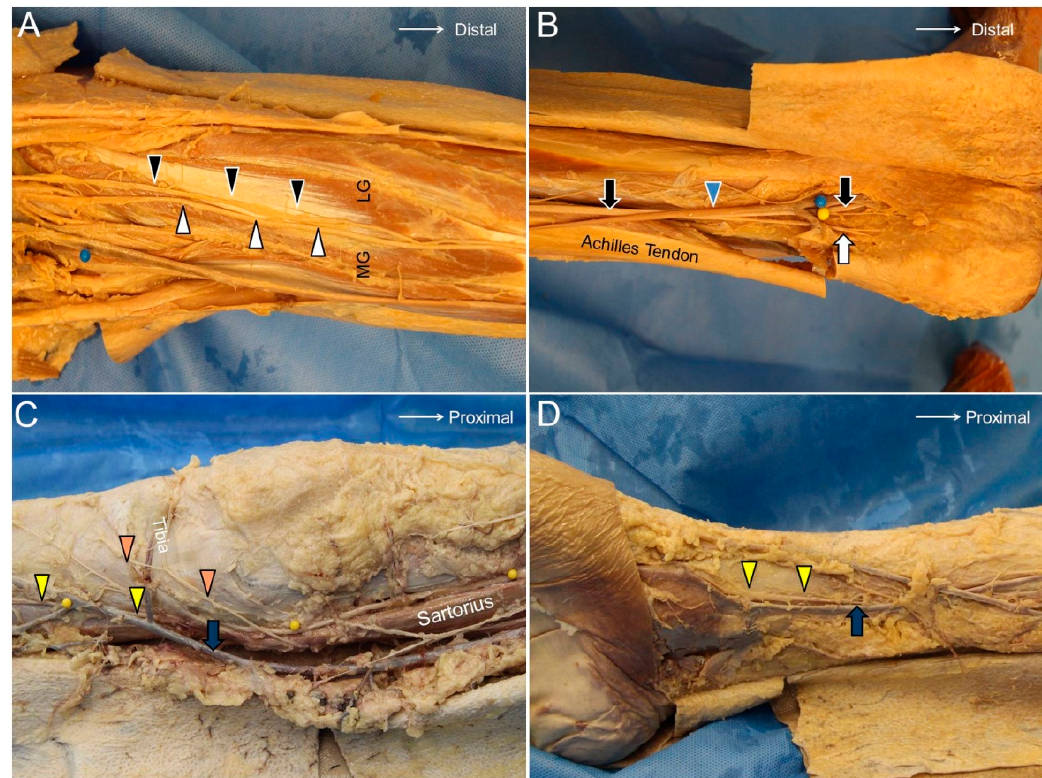
Figure 12. The medial sural cutaneous (white arrowhead) and the lateral sural cutaneous (black arrowhead) nerves of the posterior leg (A) . The sural nerve (black arrow) and its lateral sural cutaneous branch (white arrow) (B) . The infrapatellar branch (orange arrowhead) and the sartorial branches (yellow arrowhead) of the saphenous nerve crossing the knee joint (C) . The saphenous nerve accompanying the great saphenous vein coursing along the distal tibia (D) . MG, medial gastrocnemius muscle; LG, lateral gastrocnemius muscle; blue arrowhead, small saphenous vein; blue arrow, great saphenous vein.